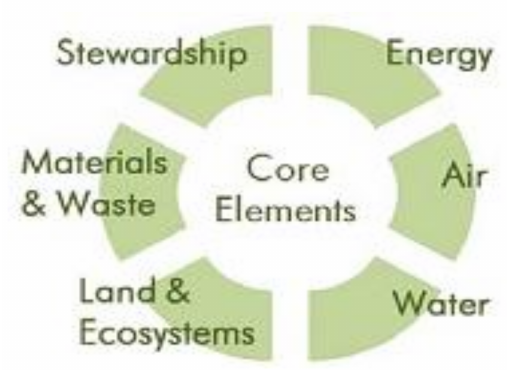
Figure 1. Core elements of green remediation